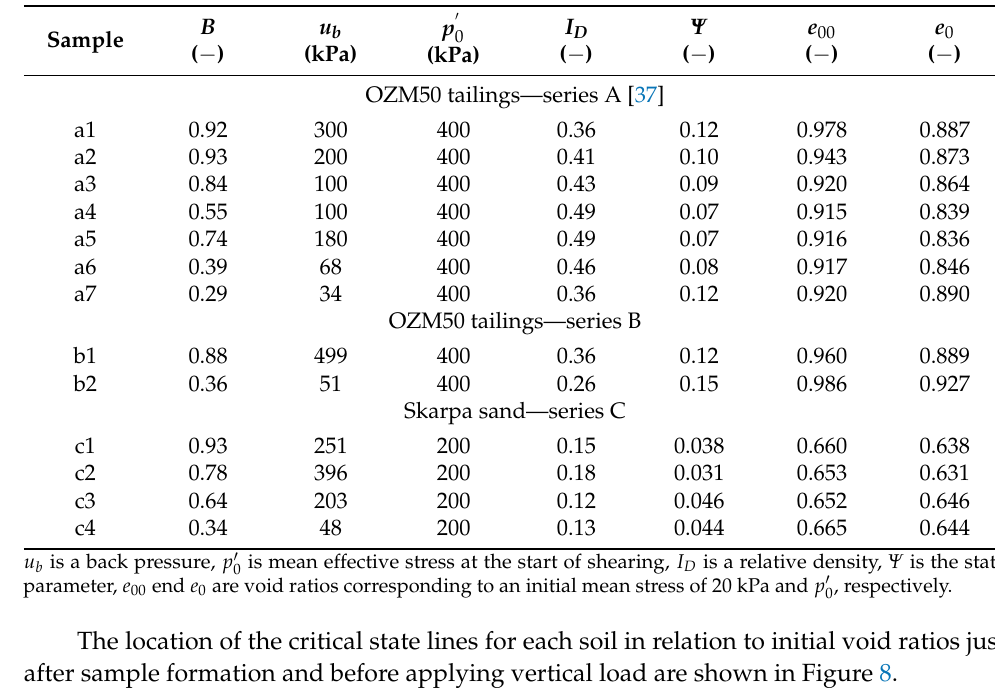
Table 2. Initial parameters of the tests.